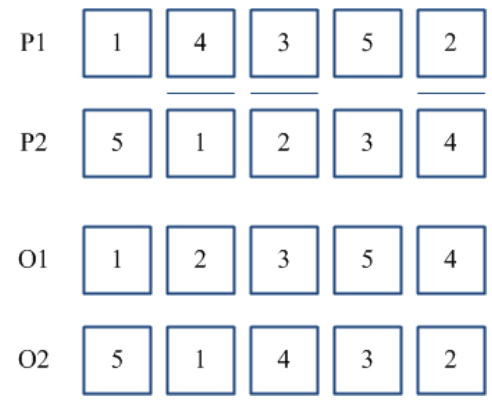
Figure 3. Position Based Crossover (PBC).